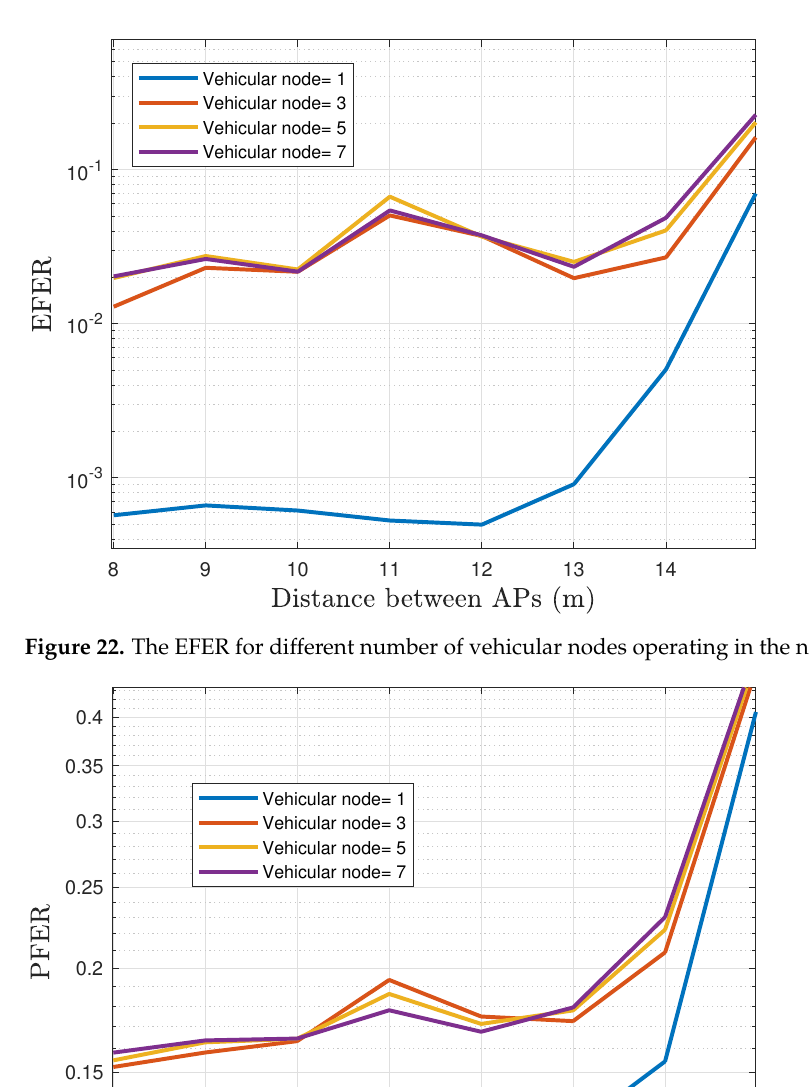
AP and the number of active vehicular nodes. Here, the data rate is reduced to 420 Kbps with m = 3, 5, and 7 vehicular nodes in the network. More interesting, it is worth noting how quickly the data rate of convergence is obtained when the separation between APs is under 14 m. It means that the solution is scalable without significant